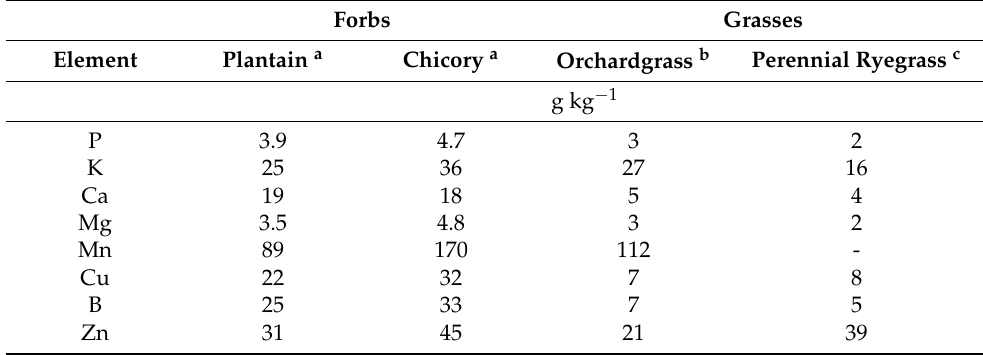
Table 2. Mineral concentrations of common forbs and grasses used in multispecies swards.